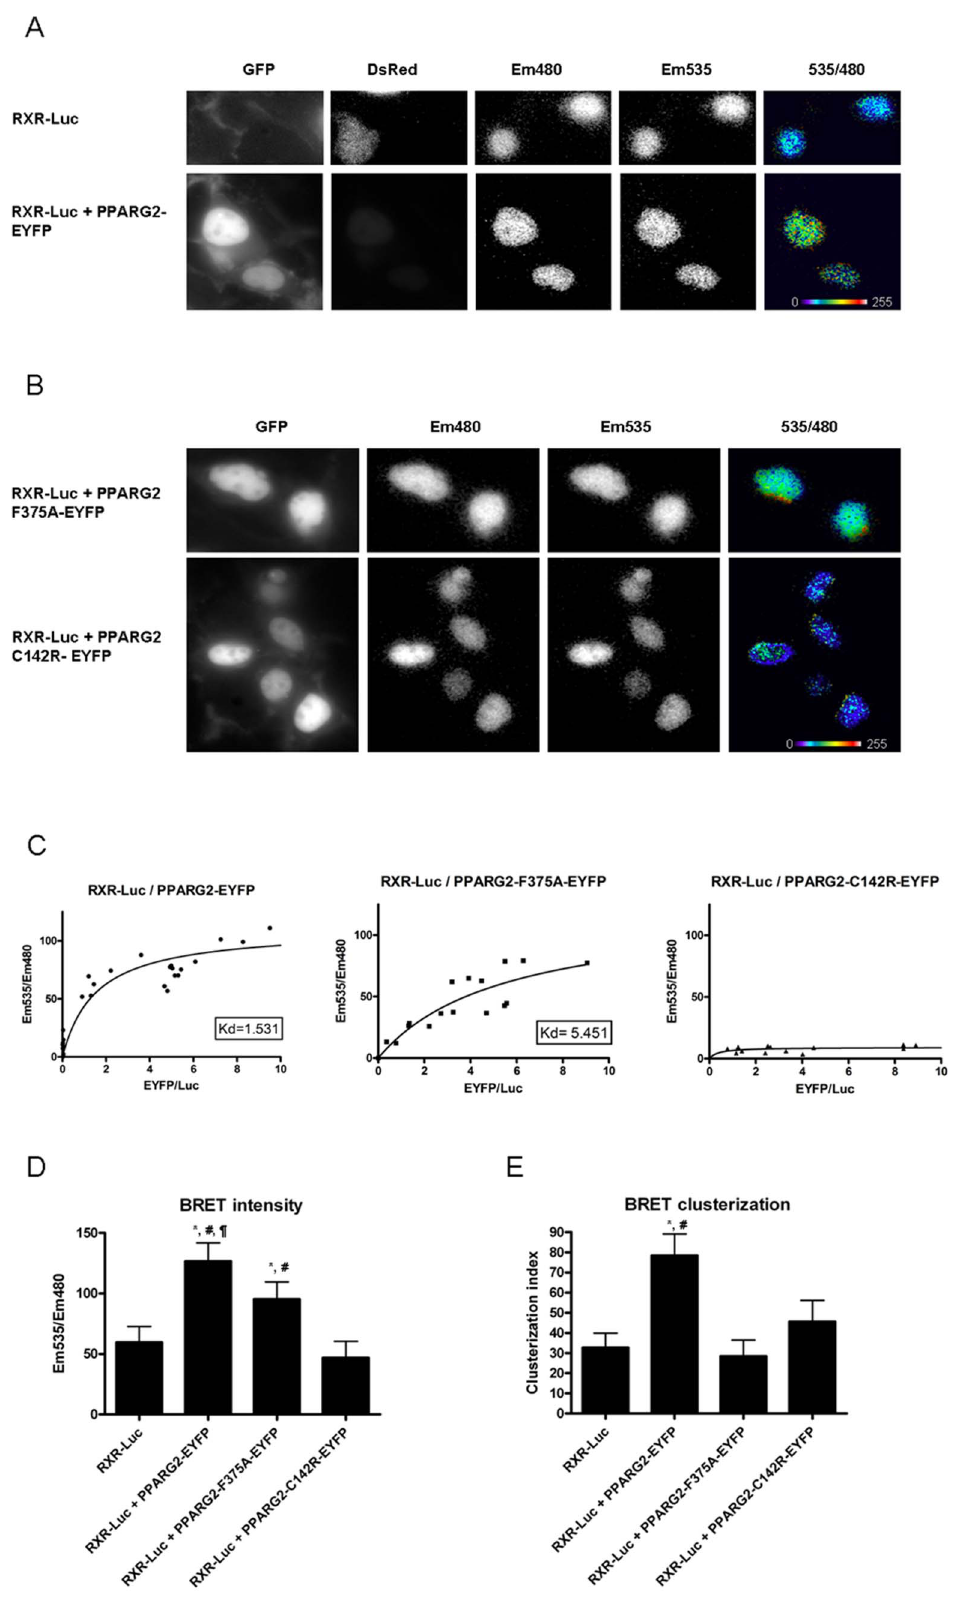
Figure 9. Subcellular localization of the interaction between RXR and PPARG2. BRET imaging was recorded in (A), HEK293T cells co- transfected with RXR-Luc and DsRed (as a transfection reporter) or RXR-Luc and PPARG2-EYFP or (B), HEK293T cells co-transfected with RXR-Luc and PPARG2-EYFP-F375A or PPARG2-EYFP-C142R. The pictures show expression of PPARG2-EYFP or mutants (GFP), RXR-Luc (Em480), PPARG2-EYFP or